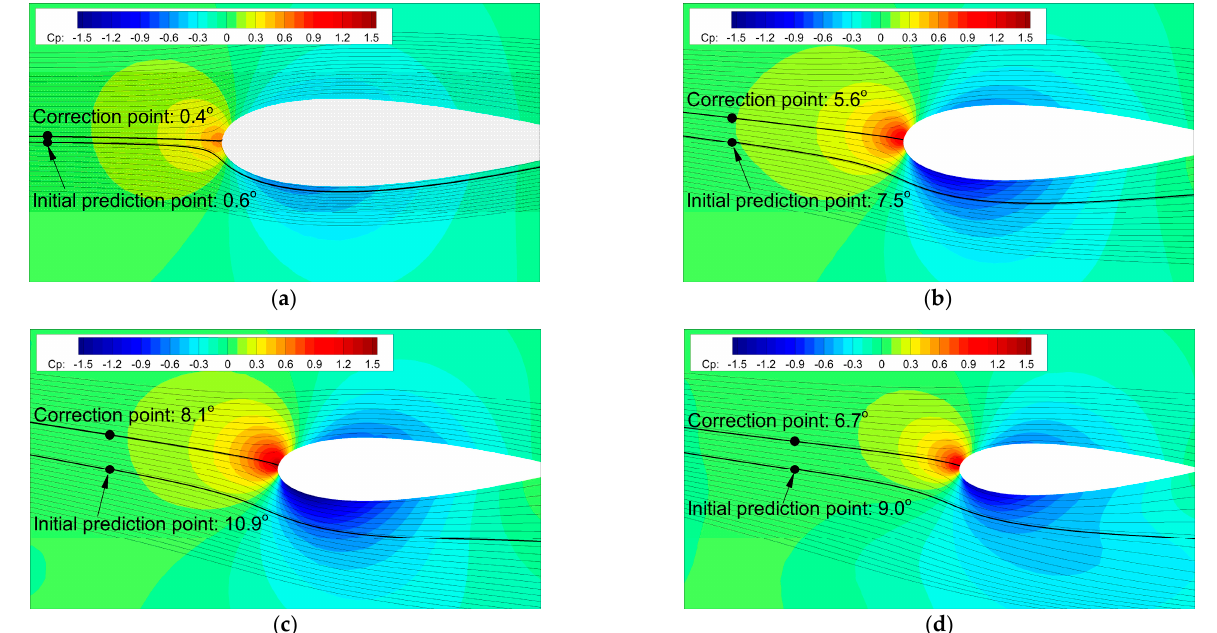
Figure 11. Prediction and correction points at which inflow angles were calculated by using the axial and transverse velocities: ( a ) z/s = 0.3; ( b ) z/s = 0.5; ( c ) z/s = 0.7; ( d ) z/s = 0.9.